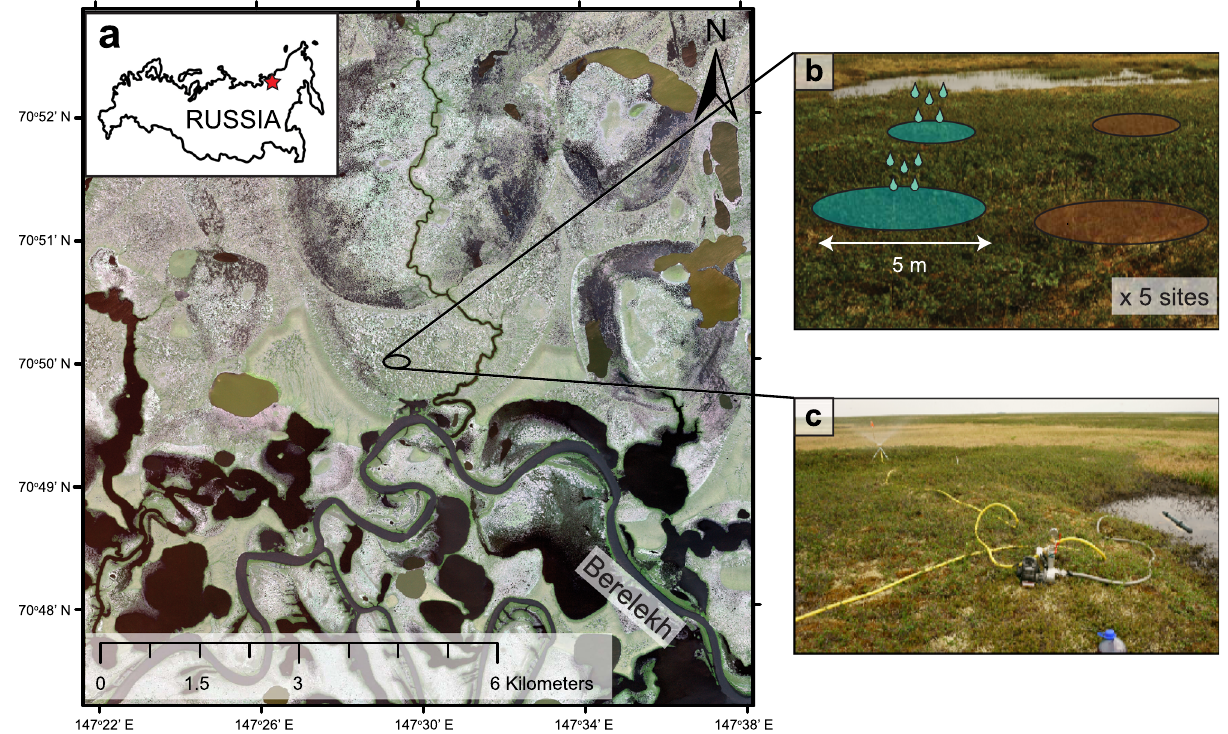
Fig. 5 Study area and experimental setup. a Our study area is situated in the Indigirka lowlands at the Chokurdakh Scienti fi c Tundra Station, in a drained thaw lake basin (alas) adjoining the fl oodplains of the river Berelekh. Image: WorldView-2 © 2019 Maxar Technologies. b In this alas, fi ve sites were selected in shrub patches within 5 – 10 m distance from a thaw pond. In each site, four circular plots were set out: two irrigated plots (blue) and two control plots (brown) each with 5 m diameter. Plots were at least 5 m apart. c The irrigation system consisted of a fi lter tube and motor pump